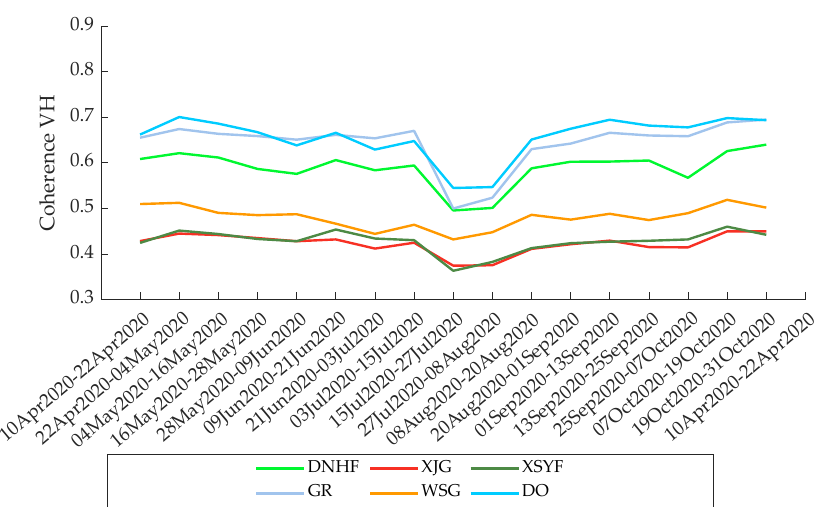
Figure 6. Temporal variation of VH coherence of different rock units.